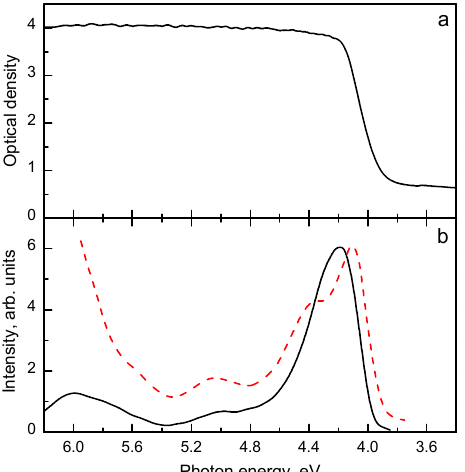
Figure 14. ( a ) Absorption spectrum of Lu 2 SiO 5 :Bi at 295 K. ( b ) Normalized excitation spectra measured at 4.2 K for E em = 3.5 eV (solid line) and E em = 3.15 eV (dashed line). Based on the data reported in [21], presented with the publisher permission.